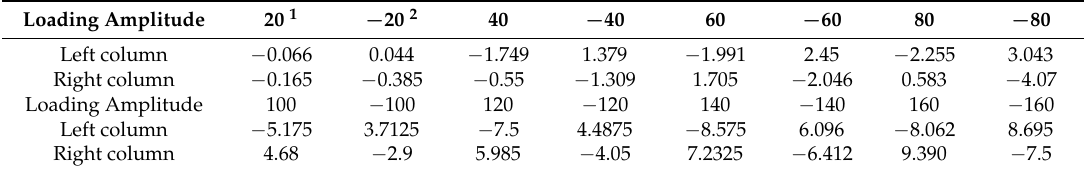
Table 7 . Amount of dislocation at each loading amplitude (Unit: mm). Table 7. Amount of dislocation at each loading amplitude (Unit: